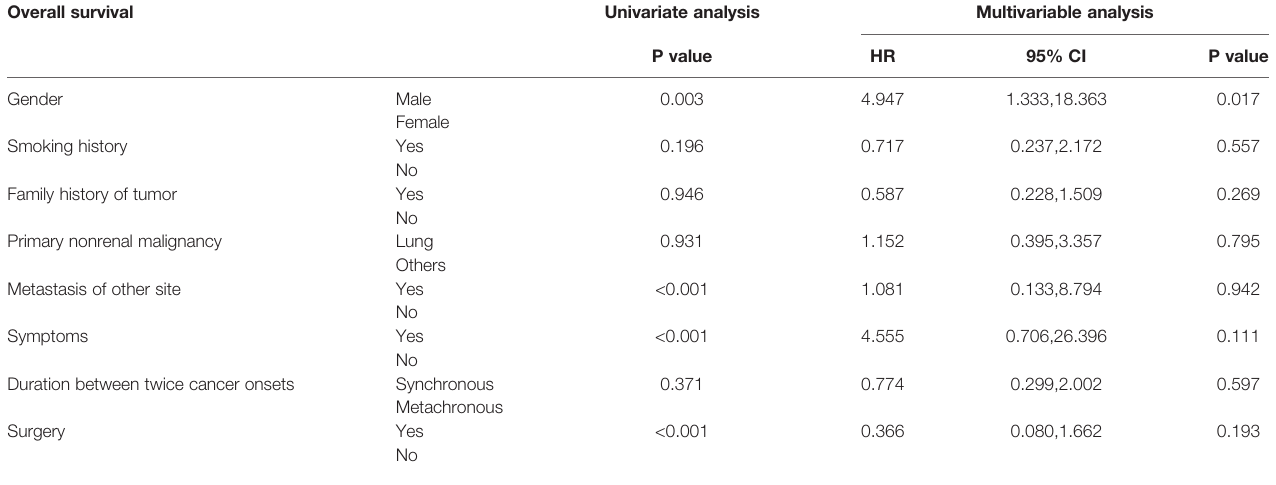
Overall survival